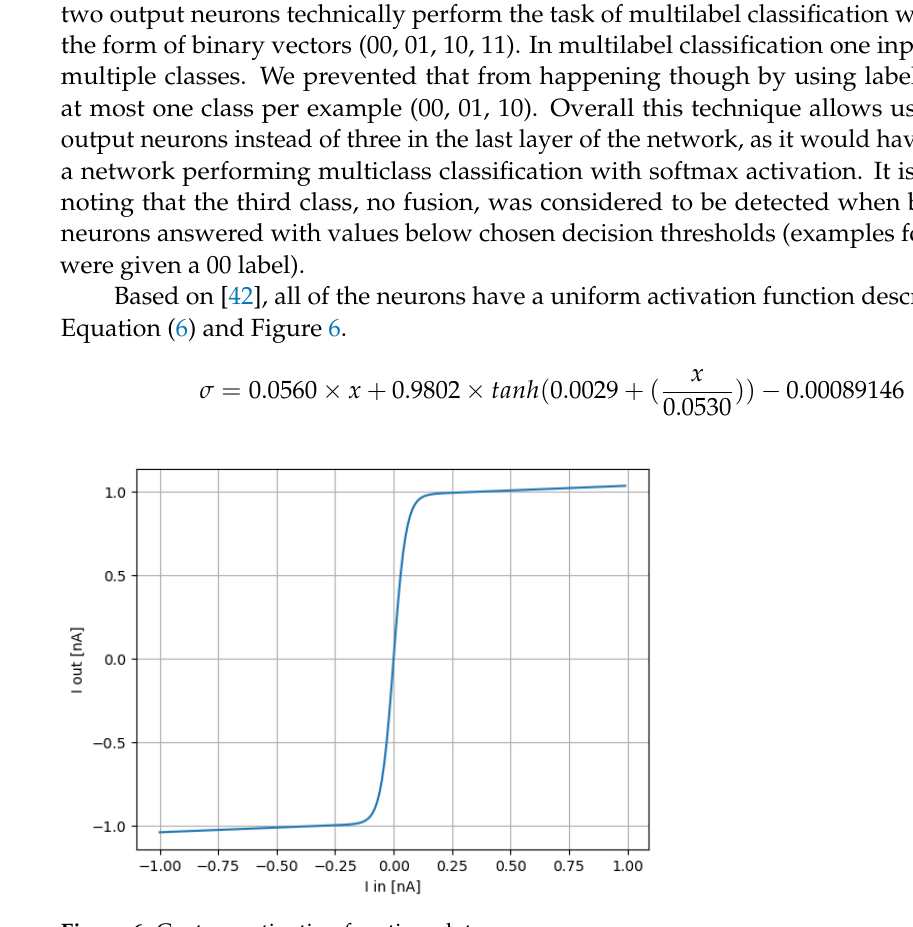
Figure 6. Custom activation function